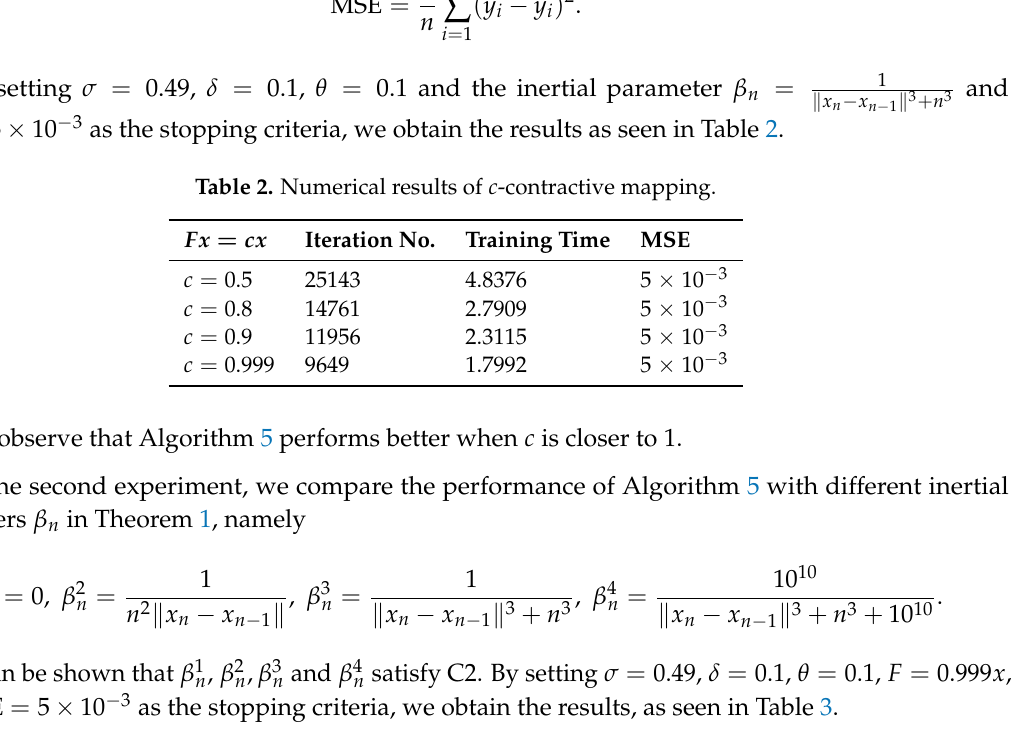
Table 3. Numerical results of each inertial parameter.